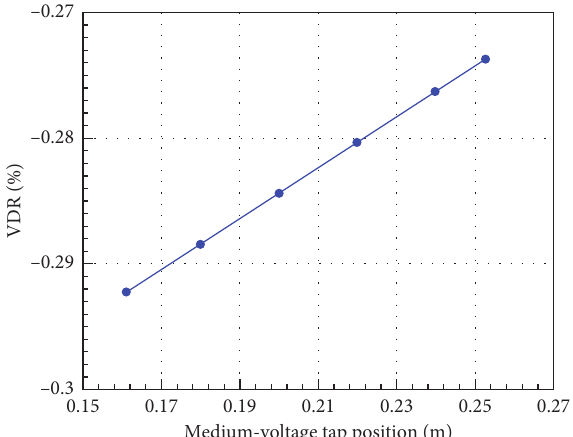
Figure 8: VDR of the CVD at different medium-voltage tap positions. The “+” and “ − ” before the value on the vertical axis represent the positive deviation and the negative deviation, respectively.